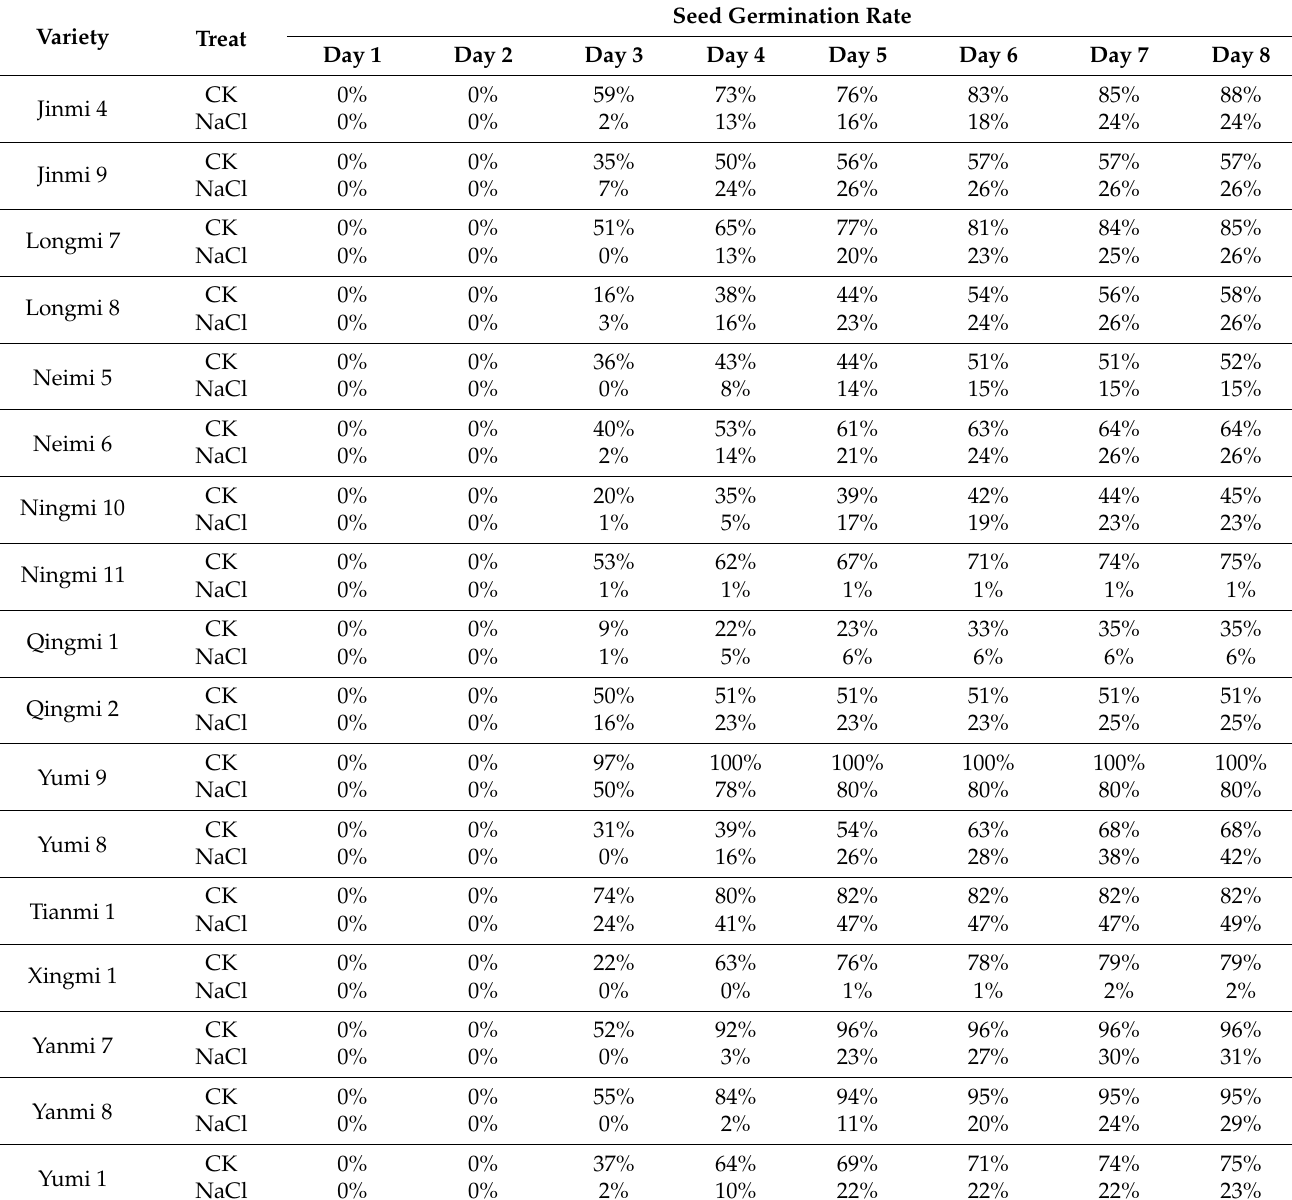
Table 1. Seed germination rate of various broomcorn millet varieties under salt